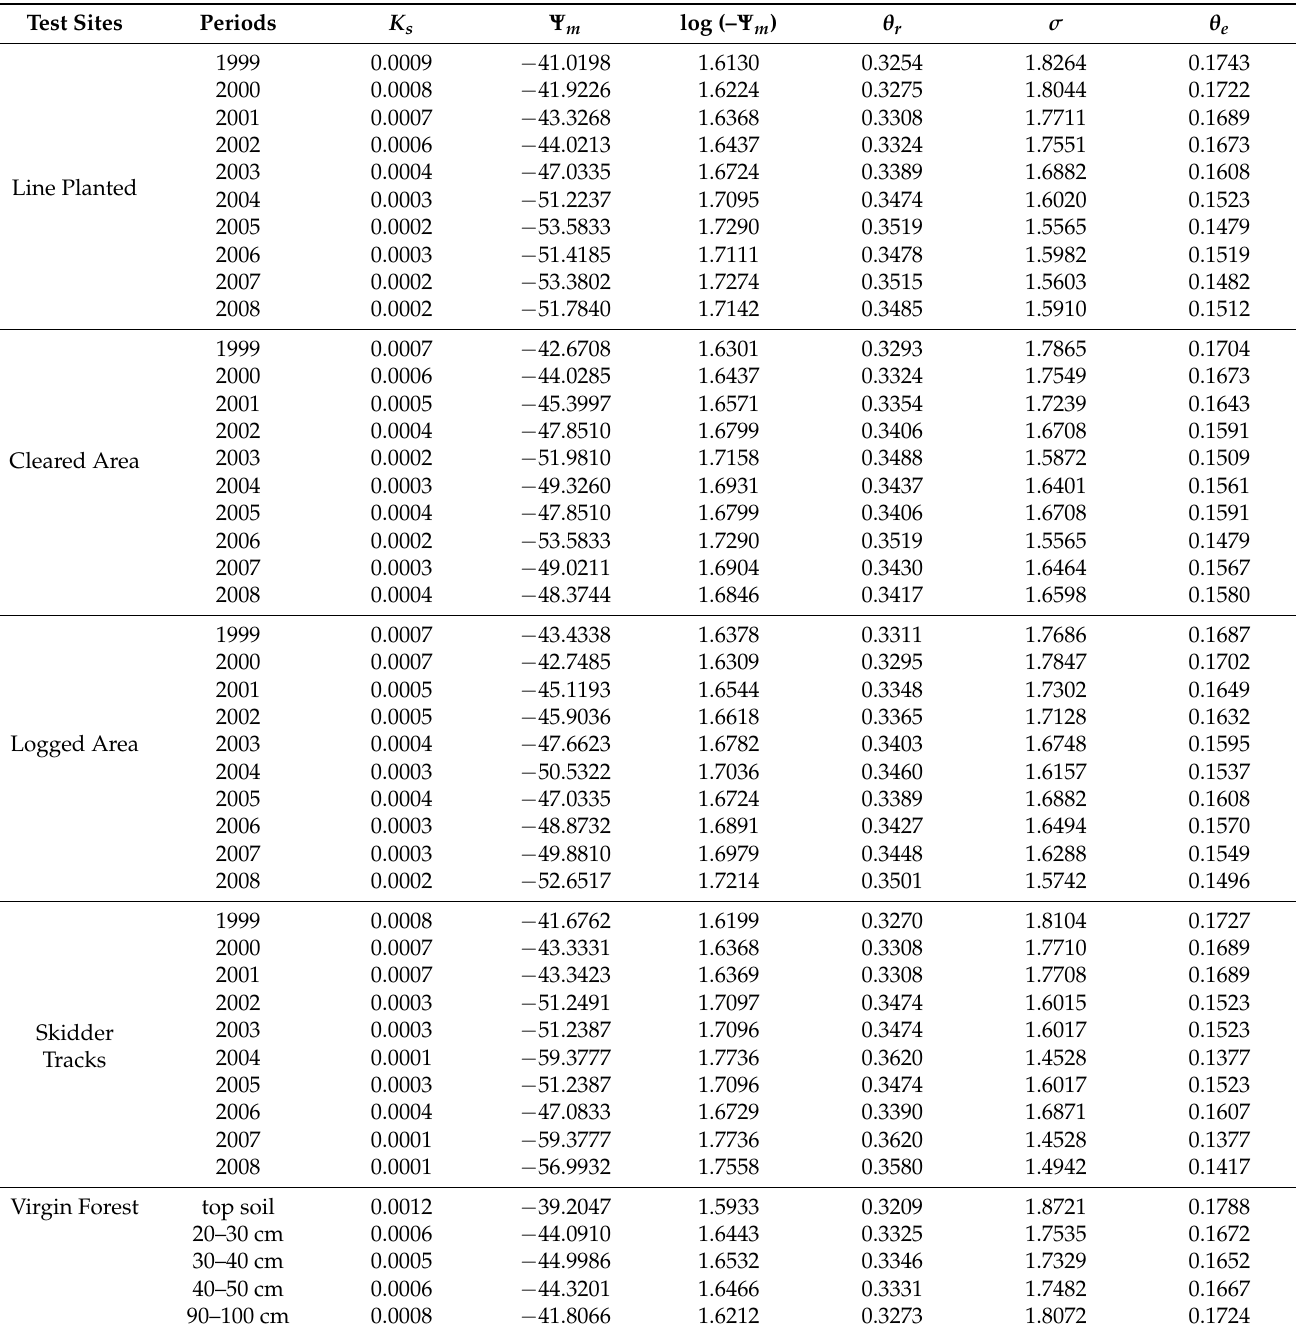
Table 1. Observed soil hydraulic properties in different periods and test sites under IFMS treatment. Test